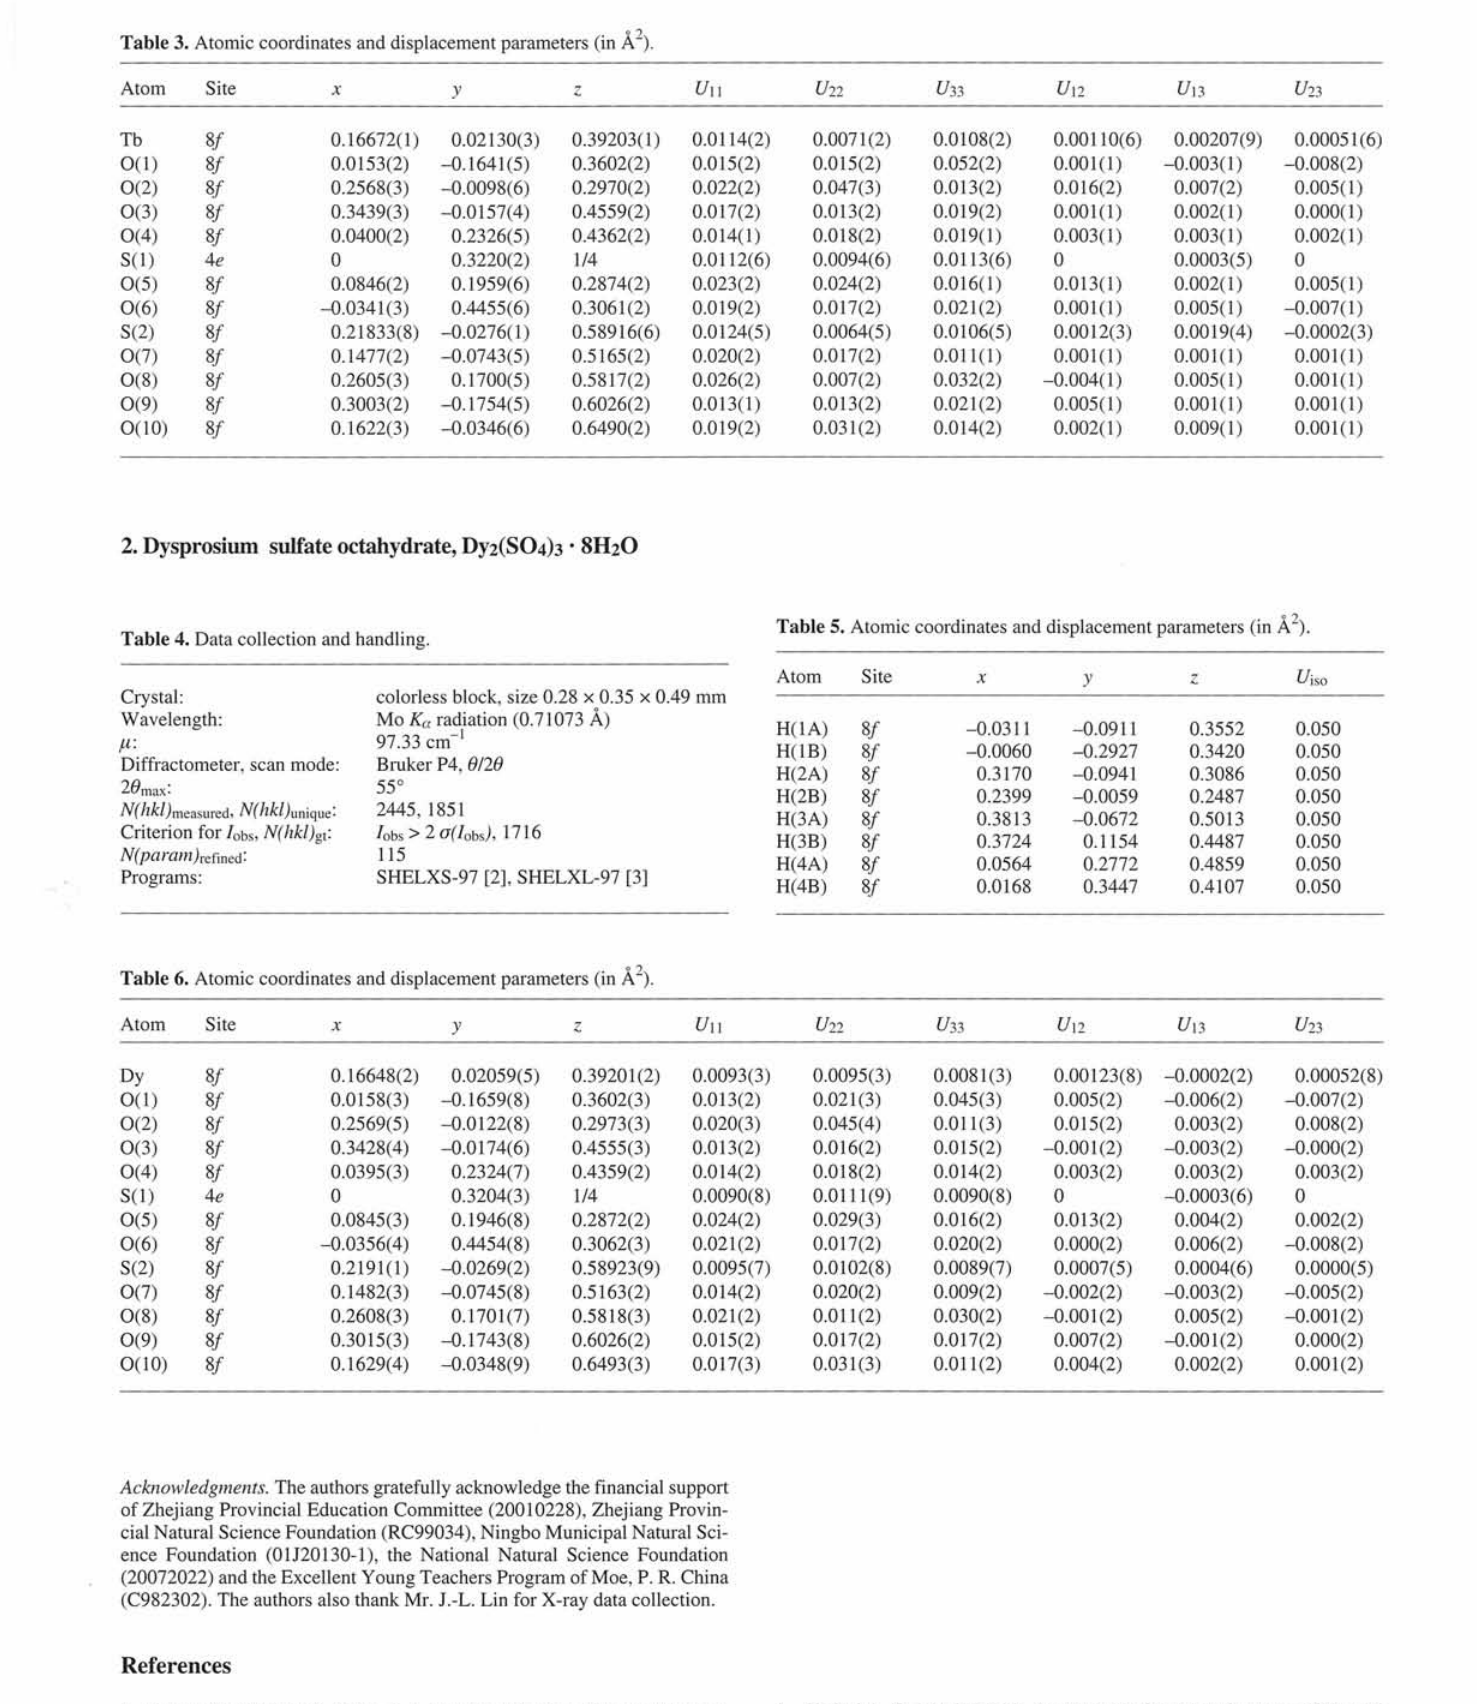
Table 3. Atomic coordinates and displacement parameters (in A").